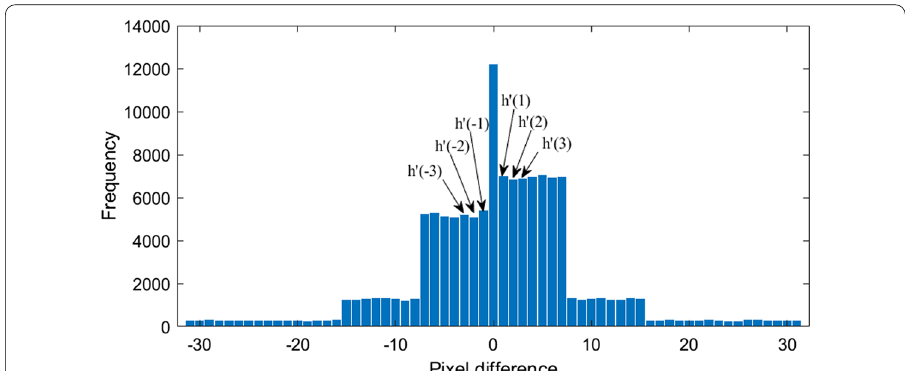
Fig. 3 PDH using PVD steganography with an embedding ratio of 100% (type 1 of the PVD interval)